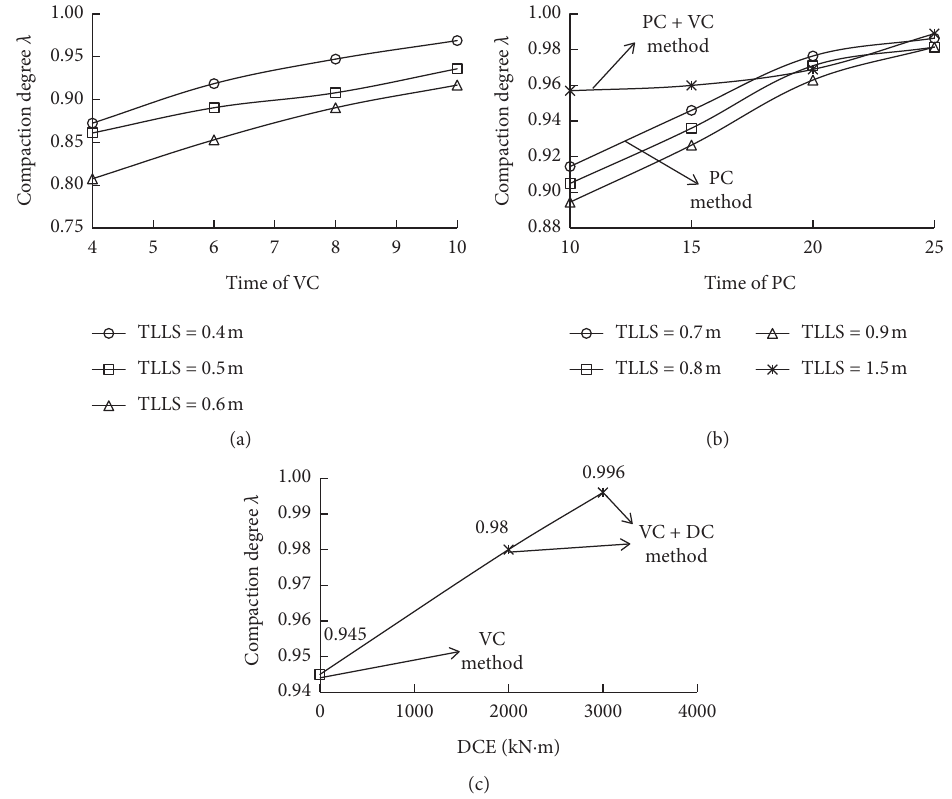
Figure 5: Compaction degree with different reinforcement methods. (a) VC method. (b) VC or VC +PC method. (c) VC or VC +DC